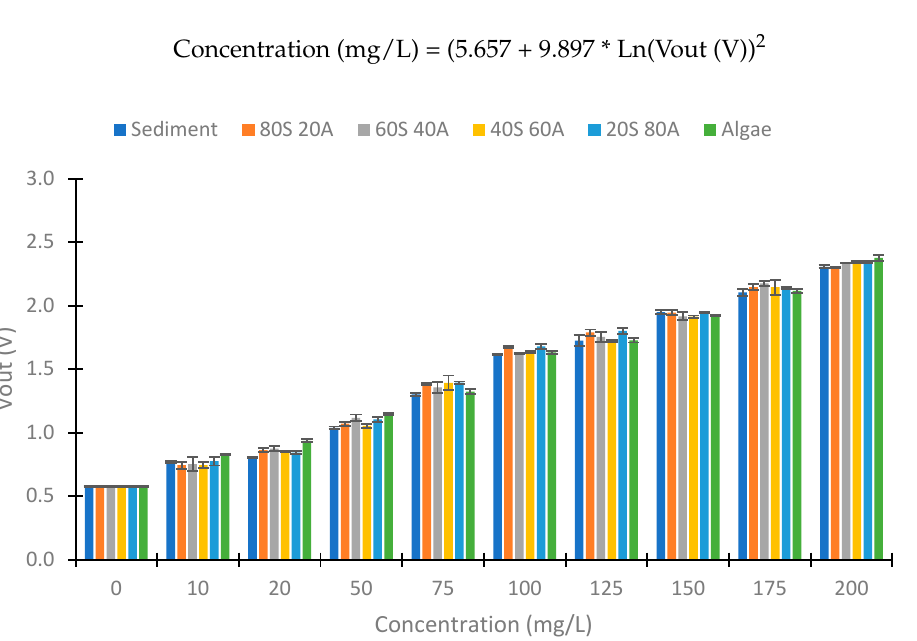
Figure 10. Vout in the voltage divider of the photodiode at 180°, with 560 Ω and 3 M Ω .